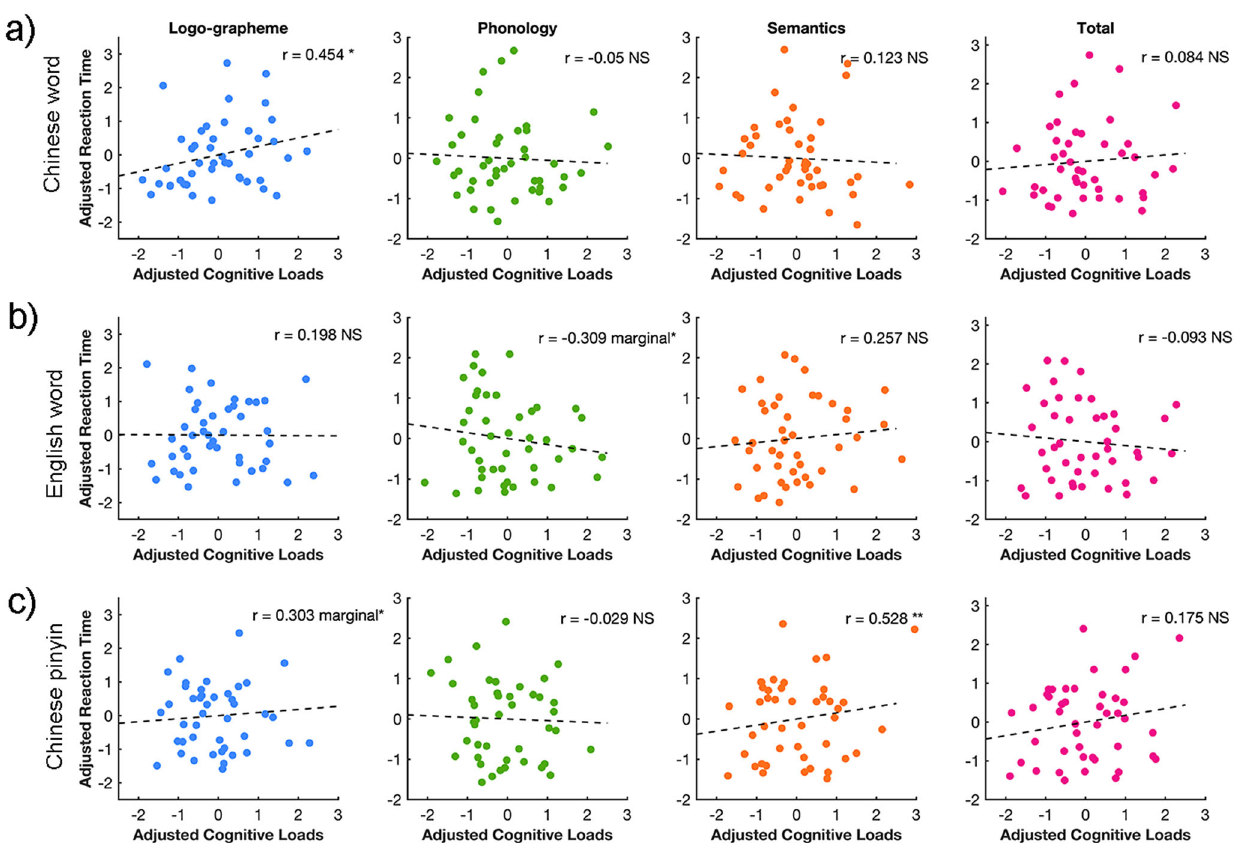
Fig. 7 The association between brain cognitive loads and reaction times of every linguistic component in each language type. Partial correlation was applied to calculate the relationship between brain activity elicited by language-processing components and reaction times for a Chinese words, b English words, and c Chinese